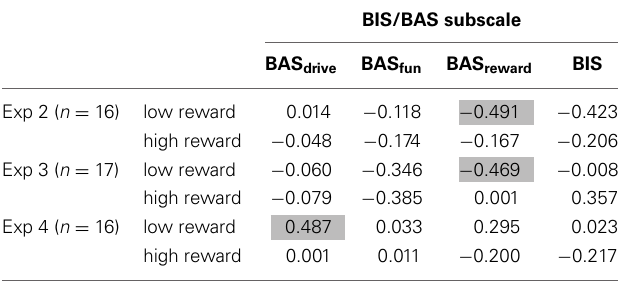
Table 1 | Correlation coefficients (Pearson’s r ) between subscales of the BIS/BAS scale and priming effects under high and low reward